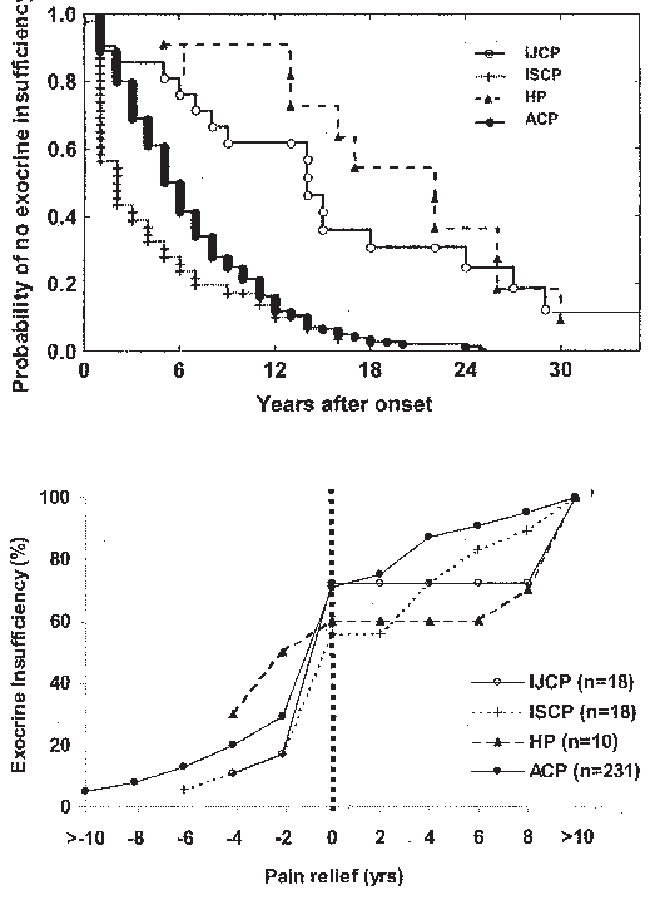
Figure 5 A close relationship between pain relief (>2 years) (Time 0) and exocrine insufficiency was observed in 60 to 80% of patients both in alcoholic (ACP, n = 231) and in non-alcoholic chronic pancreatitis ie hereditary (HP, n = 10) and idiopathic “juvenile” chronic pancreatitis (IJCP, n = 18). From this analysis patients with primary painless chronic pancreatitis were excluded (about 50% of cases with idiopathic “senile” chronic pancreatitis; <10% with ACP) or patients with opiate addiction (<5% with ACP) (see ref. [22]). Note: despite the delayed progression to exocrine insufficiency in HP and IJCP (figure 4), a similar percentage of patients got pain relief in close association with exocrine insuffi- ciency regardless of aetiology (and surgery) suggesting that the “burn-out” thesis appears valid both for alcoholic and non-alcoholic (uncomplicated) chronic pancreatitis (see text).